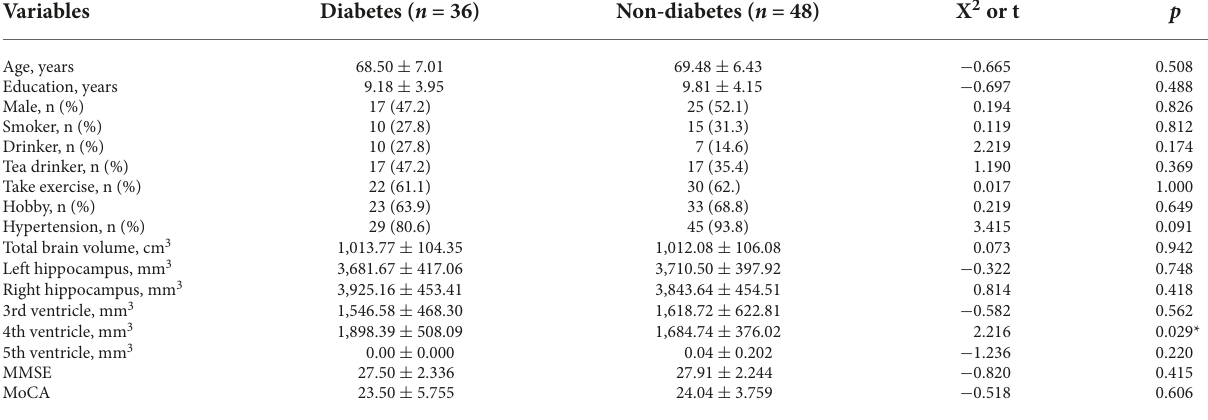
TABLE 3 Comparison of brain region structure and neuropsychological tests between diabetic and non-diabetic patients. Variables